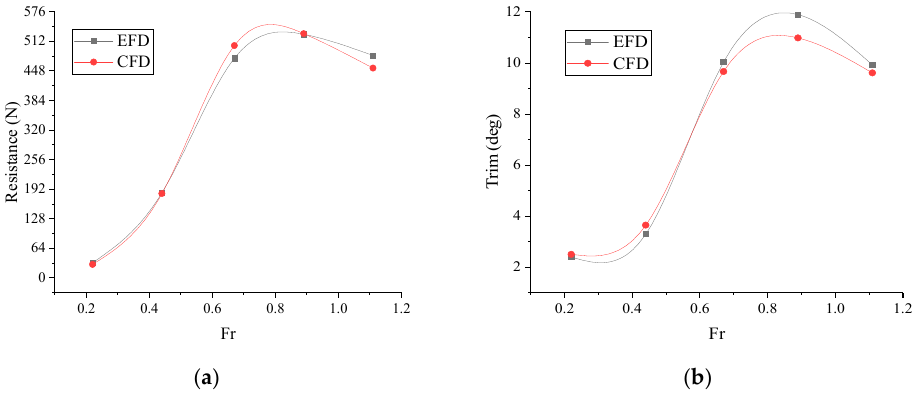
Figure 9. Comparison of results between EFD and CFD. ( a ) Resistance; ( b )Trim.